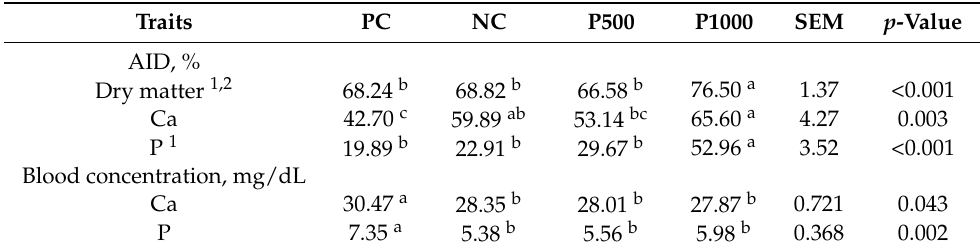
Table 3. Apparent ileal digestibility (AID) and blood concentration of calcium (Ca) and phosphorus (P) of laying hens at 31 weeks of age.